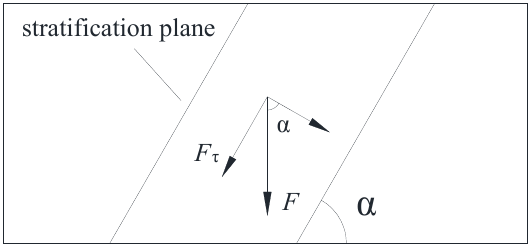
Figure 7. Mechanical model of rock samples .